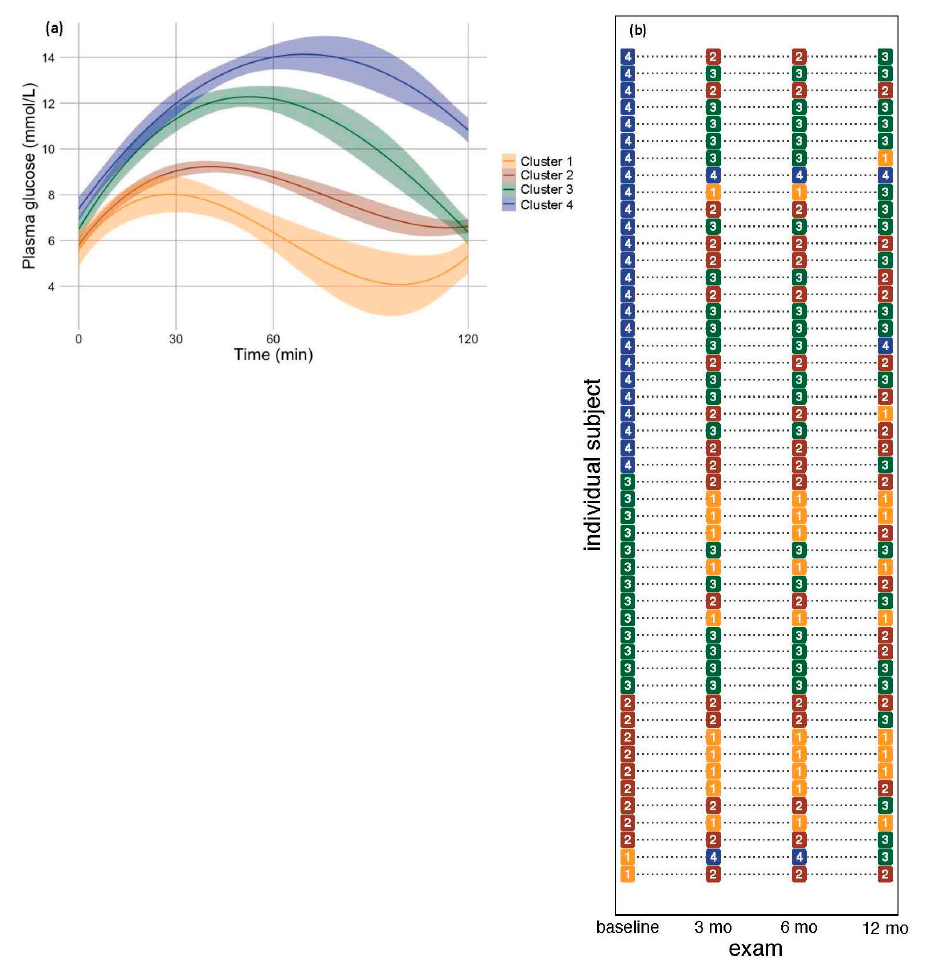
Figure 2. ( a ) Baseline latent OGTT glucose response trajectories fit with a third-order polynomial smoothing function. The shaded area represents 95% confidence intervals. ( b ) OGTT clusters for 48 (35.1% of total patients) with sufficient OGTT response data to classify the entire study period.